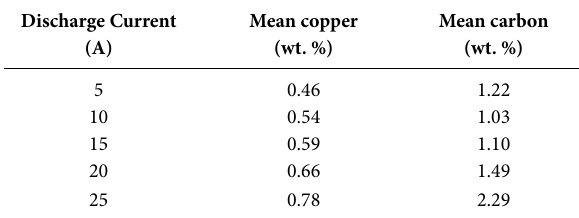
Table 8. The mean values of copper and carbon of Stainless Steel.